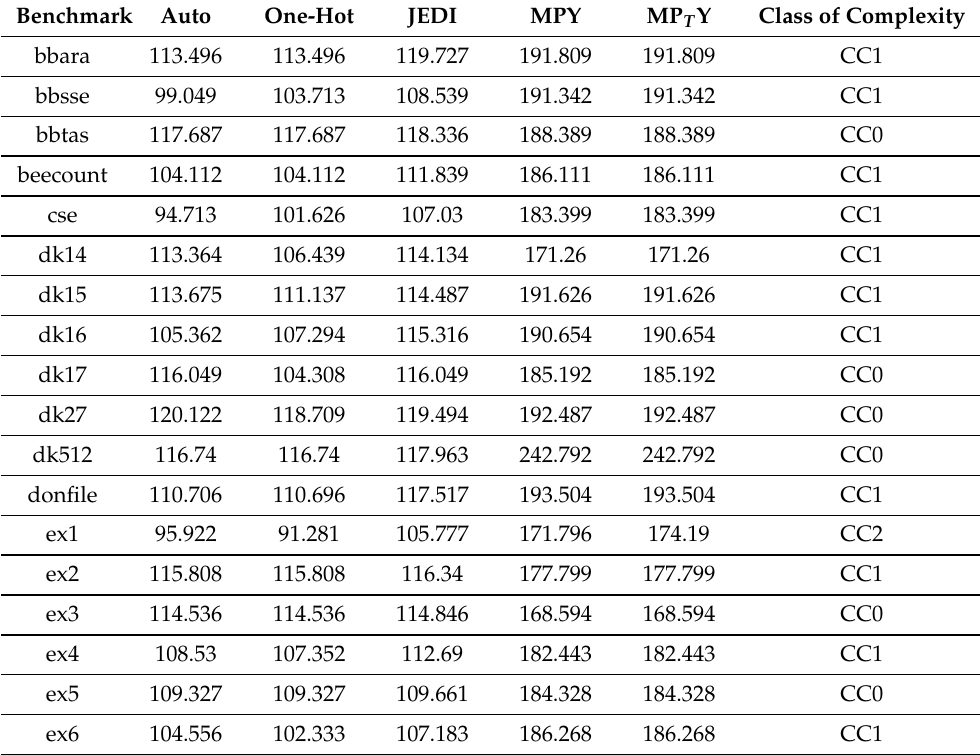
Table 14. Experimental results (the maximum operating frequency,